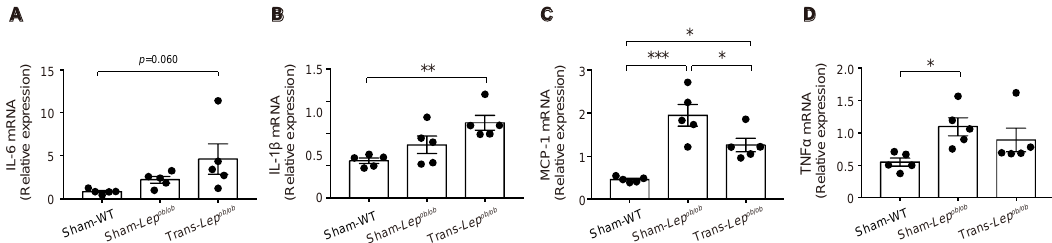
Figure 7. Effect of fat transplantation to Lep ob/ob mice on mRNA expressions of inflammation-related Figure 7. E ff ect of fat transplantation to Lep ob / ob mice on mRNA expressions of inflammation-related genes in epididymal fat tissues. A–D: Messenger RNA expressions of IL-6, IL-1β, MCP-1, and TNFα genes in epididymal fat tissues. ( A – D ) Messenger RNA expressions of IL-6, IL-1 β , MCP-1, and TNF α in Trans- Lep ob / ob , Sham- Lep ob / ob , and Sham-WT. Data are expressed as mean ± SEM. * p < 0.05, ** p < 0.01, in Trans- Lep ob/ob , Sham- Lep ob/ob , and Sham-WT. Data are expressed as mean ± SEM. * p < 0.05, ** p < *** p < 0.01, *** p < 0.001.